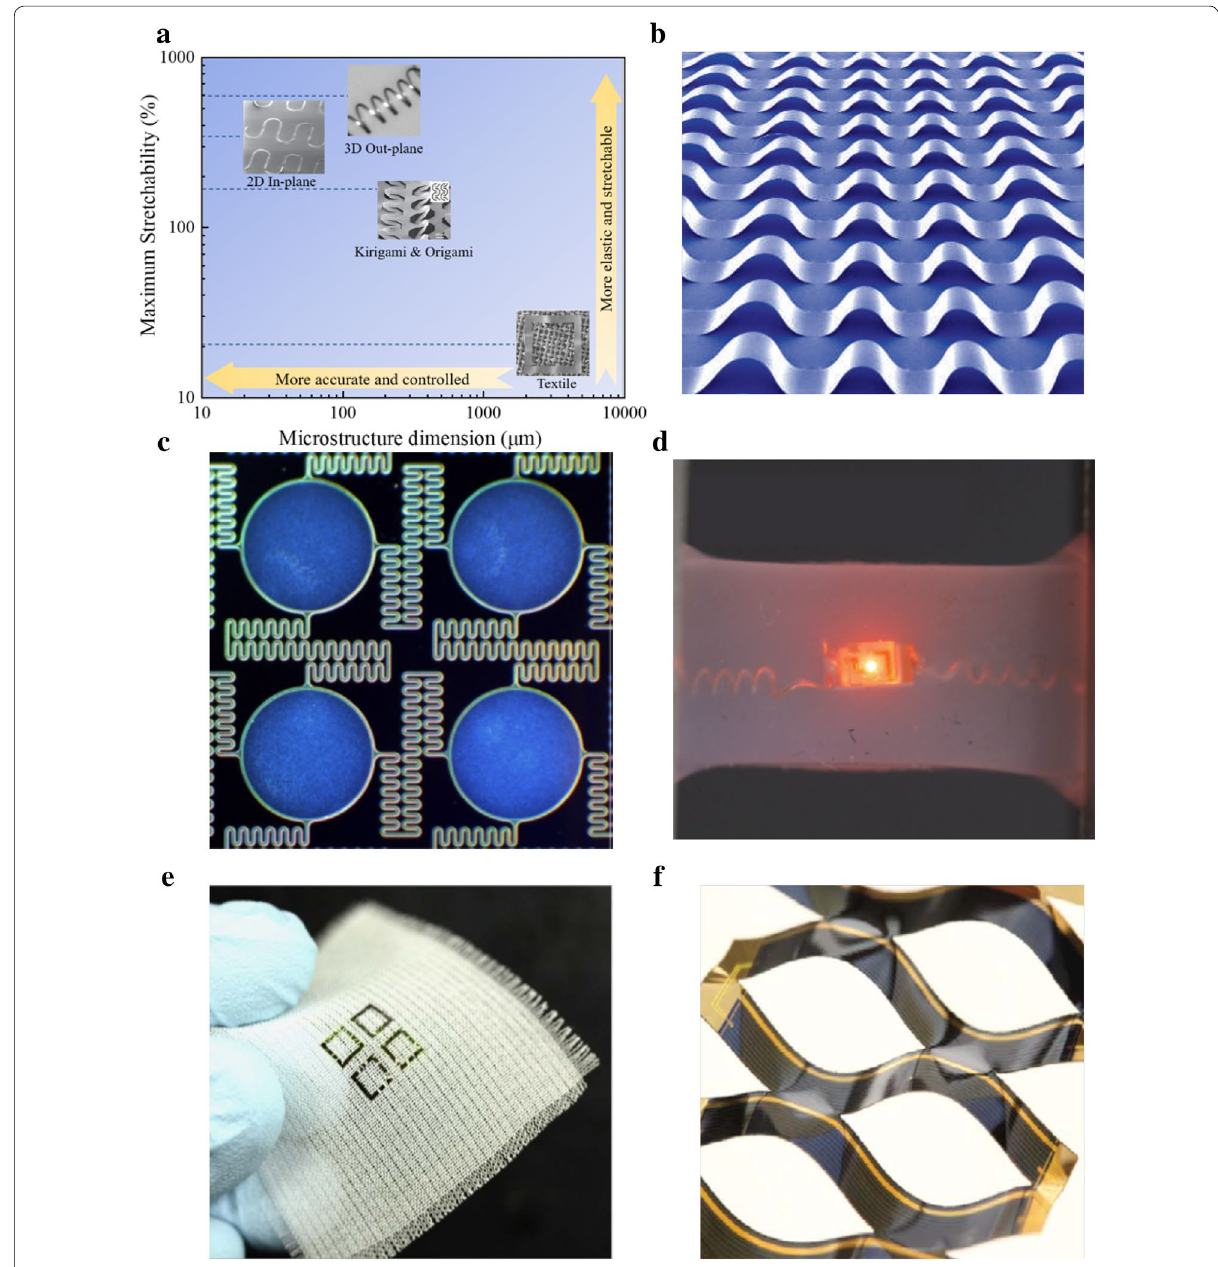
Fig. 4 Structural design for stretchable conductors. a Comparison between 2D in-plane [119], 3D out-of-plane [120], textile [121], kirigami and origami designs [122] with aspects of maximum stretchability and microstructure dimension. b Buckling strategy and wrinkle conductor. Reproduced with permission [123]. Copyright 2006, Nature Publishing Group. c 2D in planed self-similar serpentine design. Reproduced with permission [124]. Copyright 2013, Elsevier B.V. d 3D out of planed helical design [125]. e Textile structural design. Reproduced with permission [121]. Copyright 2016, Nature Publishing Group. f Kirigami structural design. Reproduced with permission [126]. Copyright 2015, Nature Publishing